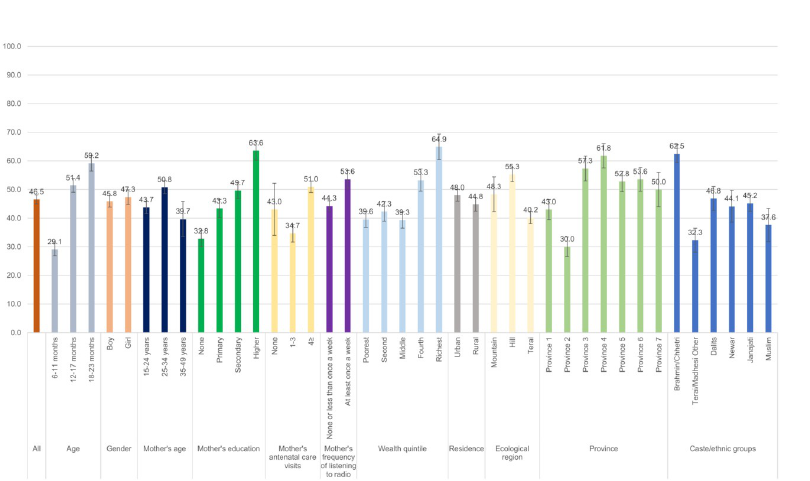
Fig 7. Percentage of Nepalese children aged 6 to 23 months consuming other fruits and vegetables by sociodemographic factors.